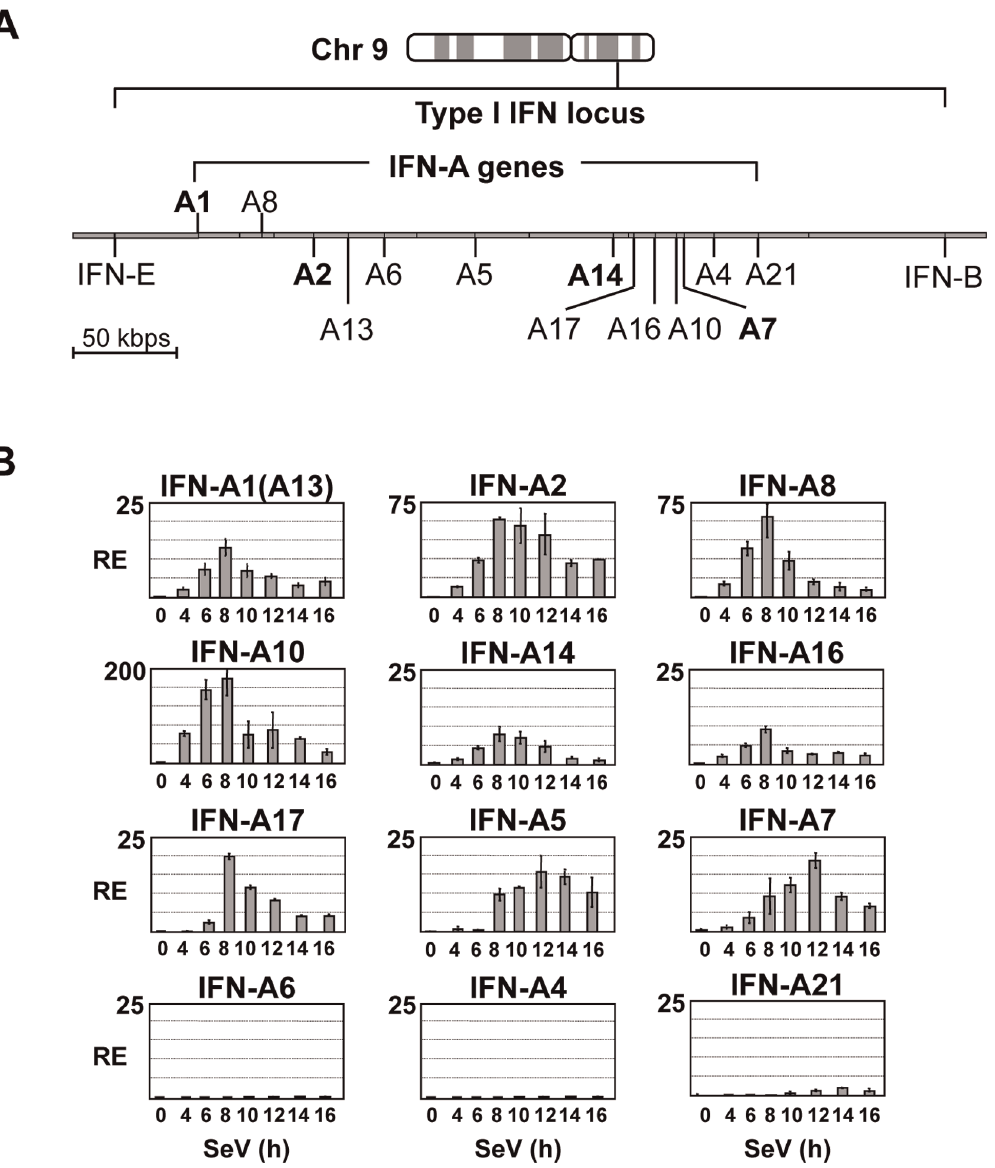
Figure 1. Expression pattern of IFN-A genes in Namalwa B cells infected by Sendai virus. ( A ) Type I IFN locus, delimited to 400 kbps on human chromosome 9, consists of thirteen intronless IFN-A genes located in cluster with the IFN-B and IFN-E genes (data retrieved from NCBI library, version 37.1). IFN-A genes analyzed in this study are indicated in bold in the diagram. IFN-A1 and IFN-A8 are in reverse orientation compared to other IFN-A genes. ( B ) IFN-A gene expression was determined by quantitative RT-QPCR analysis in Namalwa B cells mock-infected (0 h) or infected by Sendai virus for 4–16 h. IFN-A1 expression levels presented in this study represent the total amounts of both IFN-A1 and IFN-A13 mRNAs; the high percentage of sequence homology of IFN-A1 and IFN-A13 genes (99.7% in the coding region) did not allow distinction between these genes. Relative expression (RE) normalized to GAPDH mRNA levels is indicated with standard deviation values calculated in two independent experiments performed in